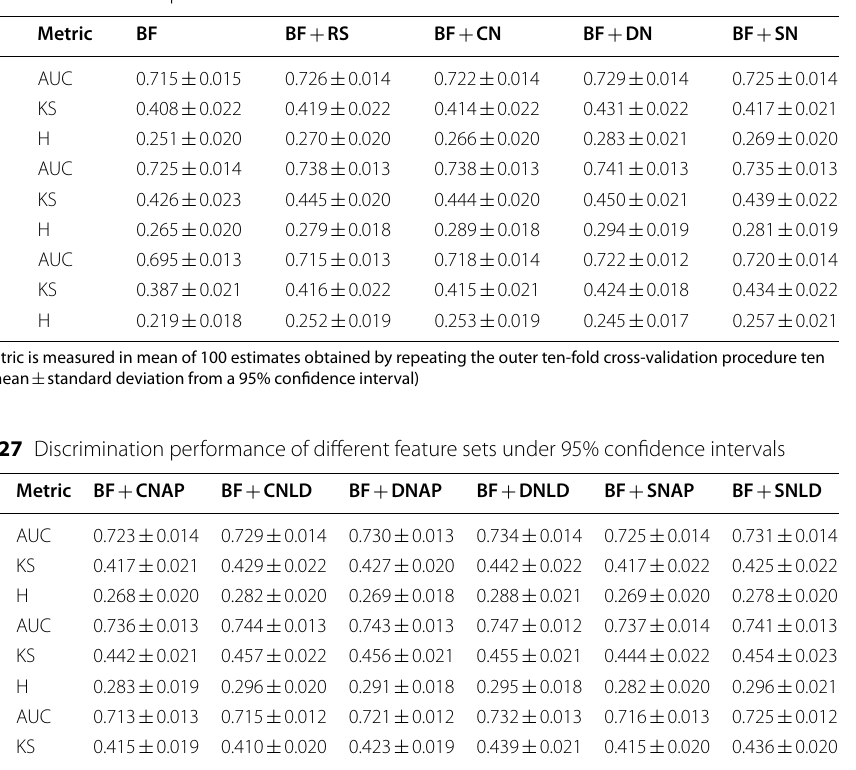
Table 26 Discrimination performance of different feature sets